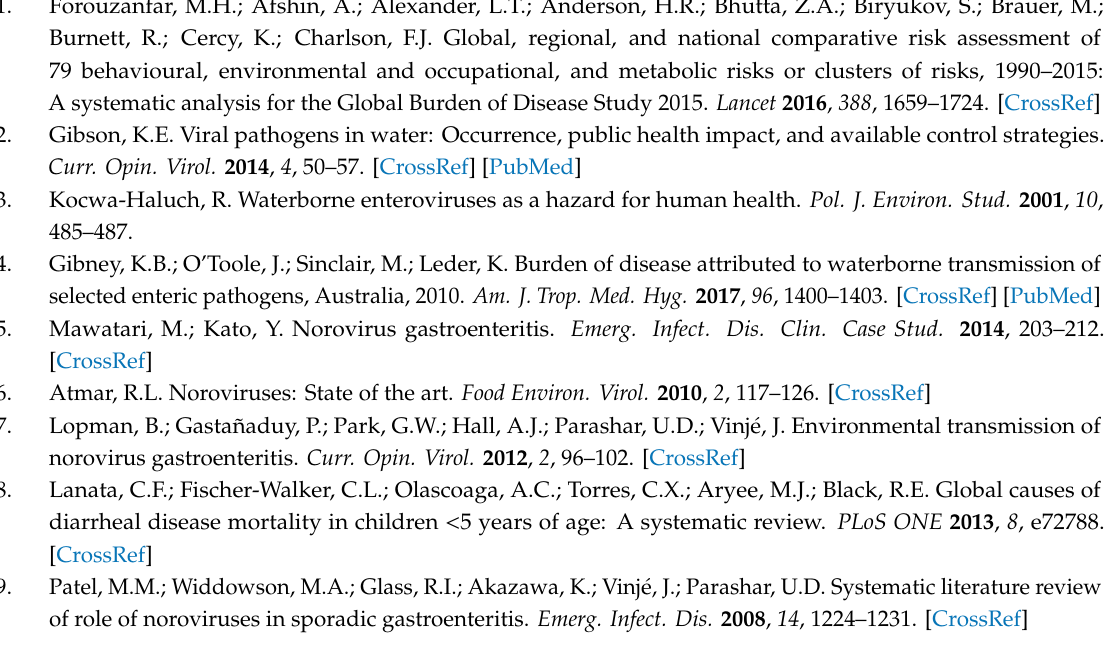
GD1a-positive bacterial strains from the sewage